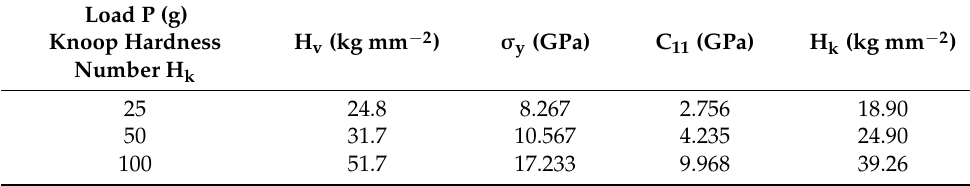
Table 5. Mechanical characteristics of UGA.